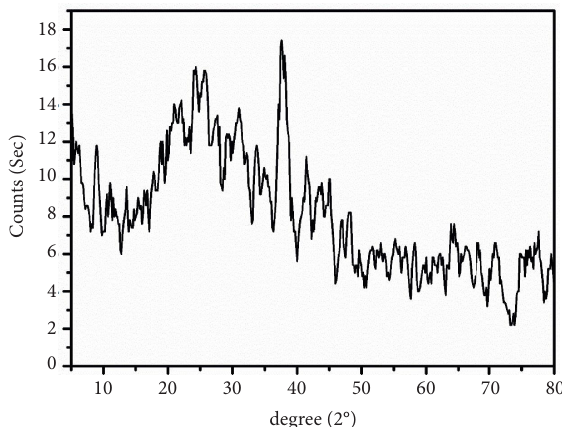
Figure 4: X-ray diffraction analysis of silver nanoparticles bio- synthesized by Cystoseira myrica